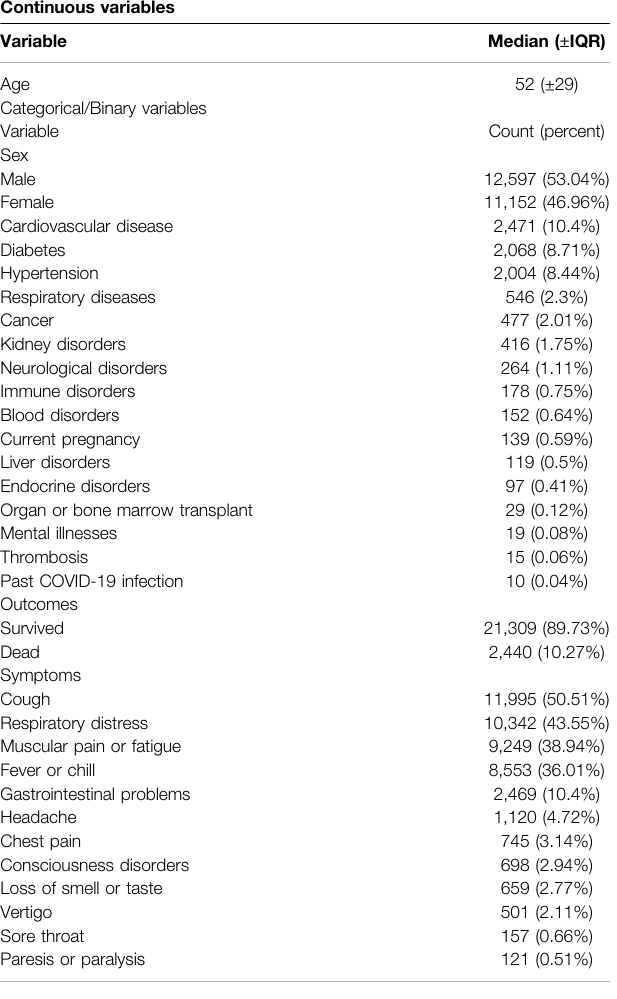
TABLE 2 | Patient characteristics and symptoms. Baseline characteristics, symptoms, and death outcomes for COVID-19 patients. Continuous